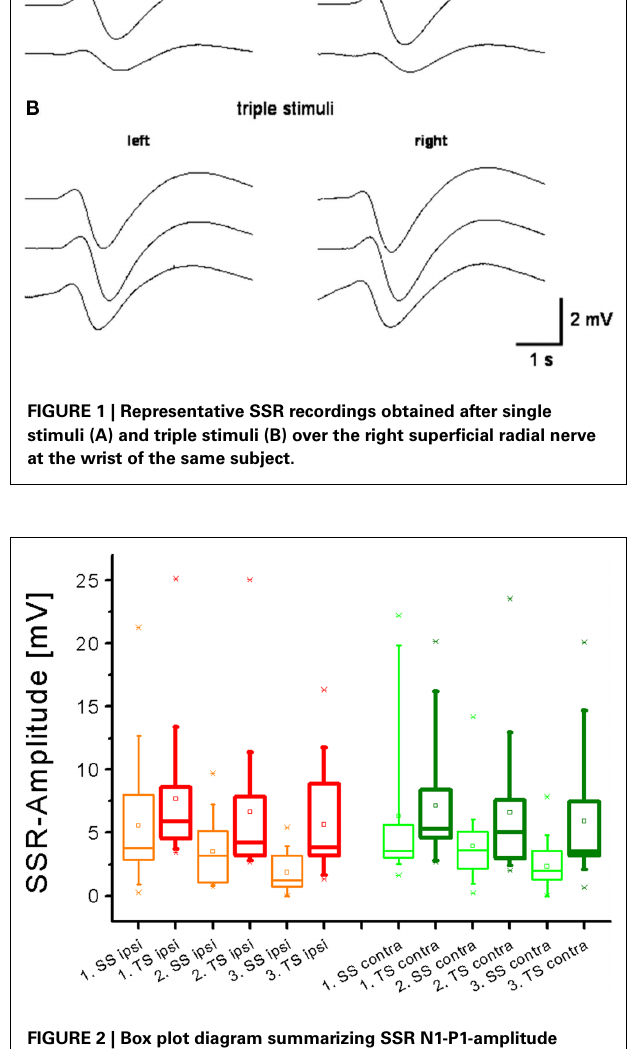
FIGURE 2 | Box plot diagram summarizing SSR N1-P1-amplitude values obtained in the entire sample after single stimuli (SS) and train stimuli (TS) delivered over the right superficial radial nerve. A significant amplitude decline was obtained on either side with SS but not withTS (Friedman test).